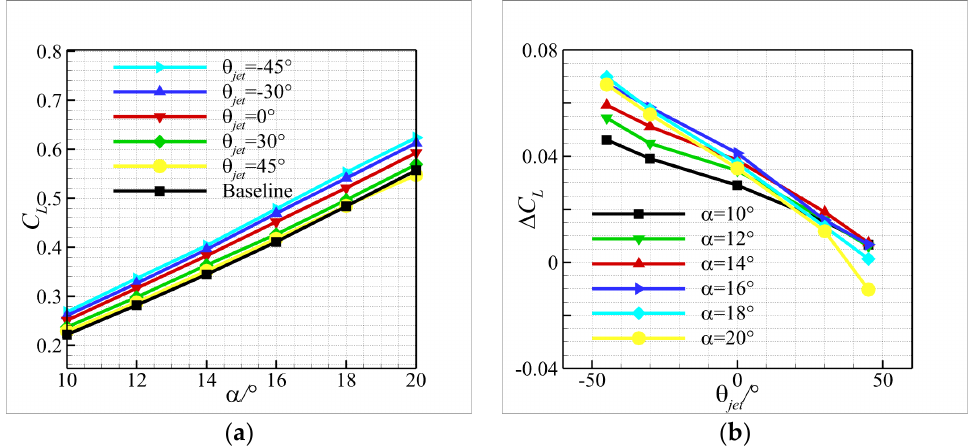
Figure 21. Changes in lift by the lateral jets with different blowing directions. ( a ) Lift coefficient; ( b ) Lift coefficient augmentation.